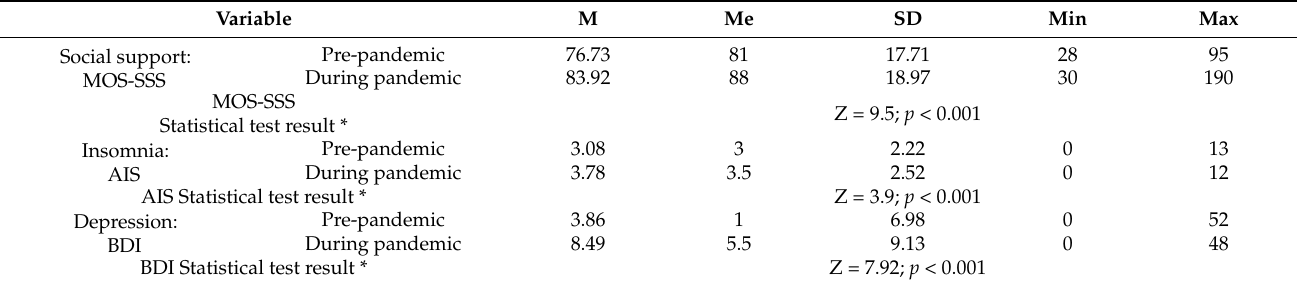
Table 2. Comparison of social support, sleep disorders and depressive symptoms in the pre-pandemic period and during the pandemic among healthcare